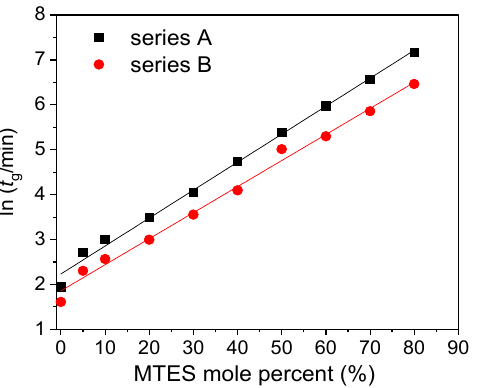
Figure 1. Gelation time ( t g ) as a function of the MTES/TEOS molar ratio at two catalyst concentrations (series A and series B labels represent the pH = 2.0 and pH = 4.5).